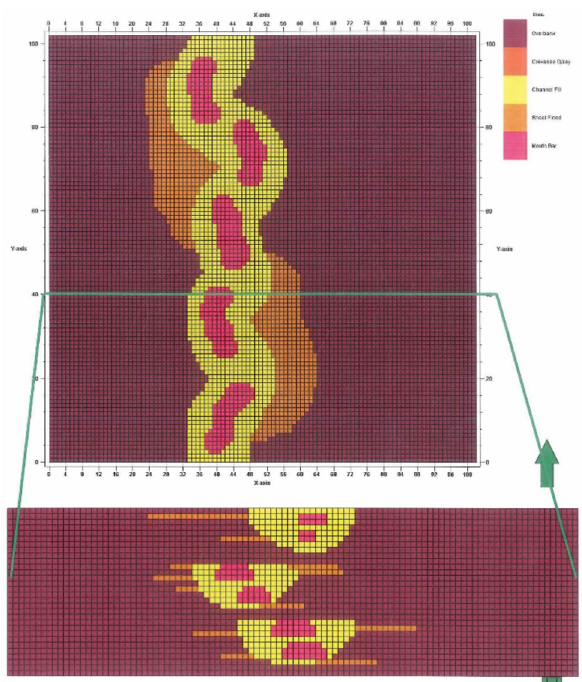
Fig. 16 Training image for transition area in cross horizontal and ver- tical section